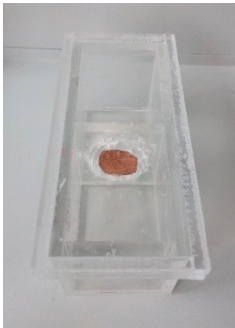
Figure 4. One of the model plexiglass boxes for experiments with calcium diffusion.